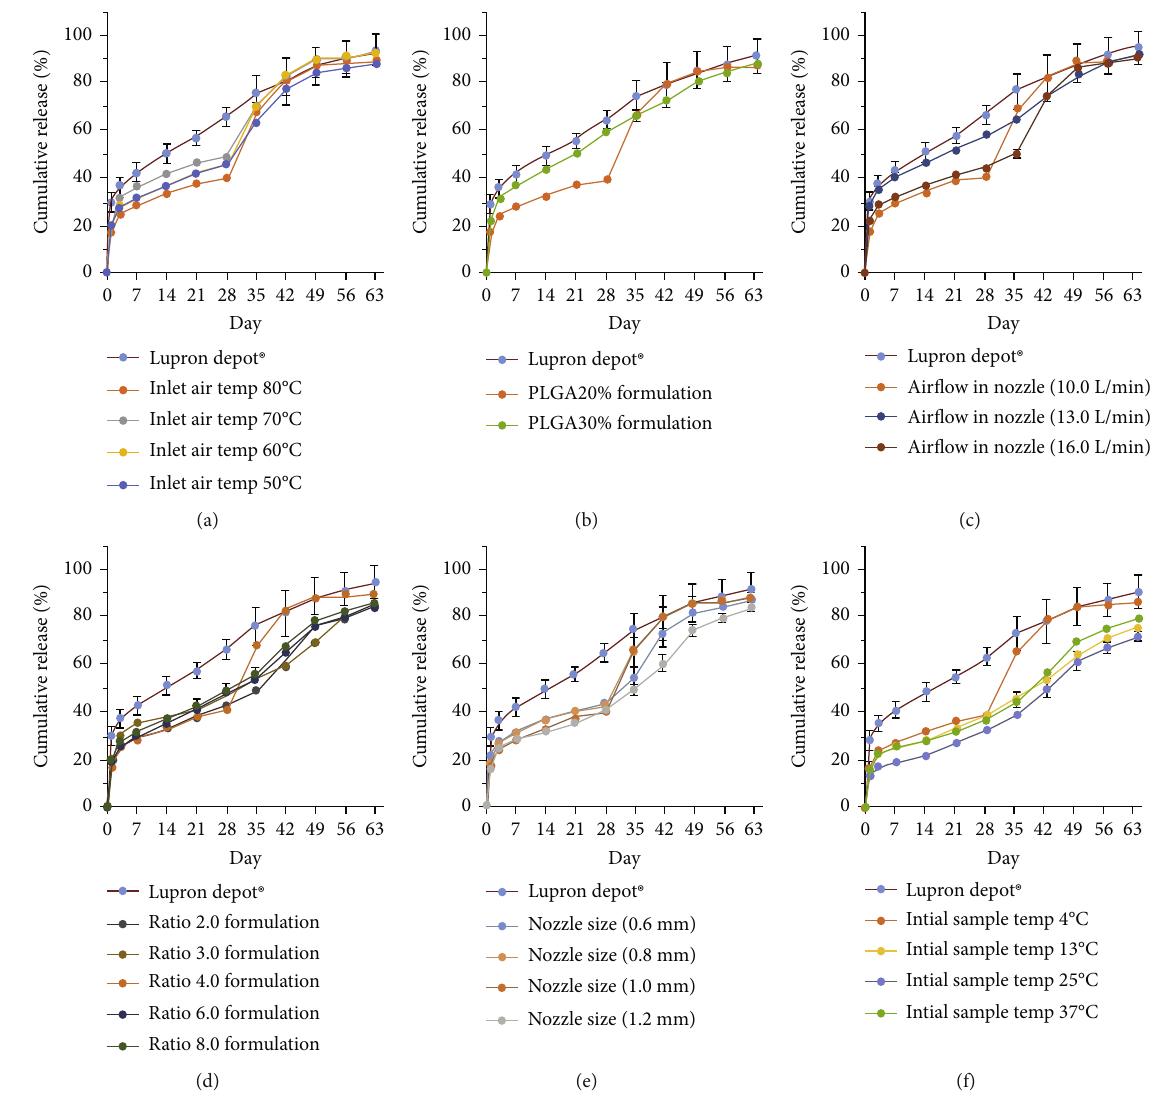
Figure 39: Cumulative release of leuprolide from all formulations of spray-dried microspheres and the Lupron Depot® (LD). Microspheres were incubated in PBST (pH7.4) at 37 ° C. Panels are grouped according to formulations with varied spray drying parameters, including inlet , a), PLGA concentration ( C , b), air fl ow in nozzle ( AF , c), ratio between atomization gas fl ow rate and the air temperature ( T inlet feed nozzle , d), nozzle size ( S , e), and initial sample temperature ( T , f). The basic formulation (orange liquid mass fl ow rate ( Ratio A / L nozzle feed symbols) and LD are listed in each panel as controls. Symbols represent mean ± S : D ( n = 3 [116]).